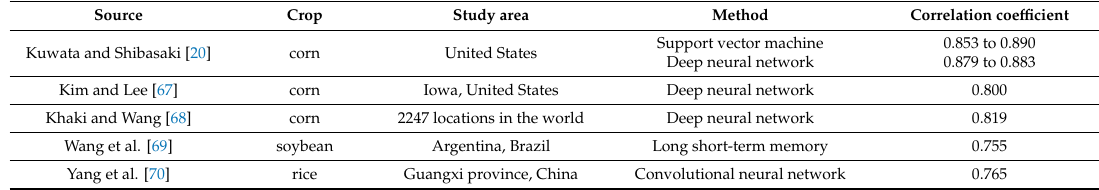
Table 8. Result of crop yield estimation using artificial intelligence (AI) from previous